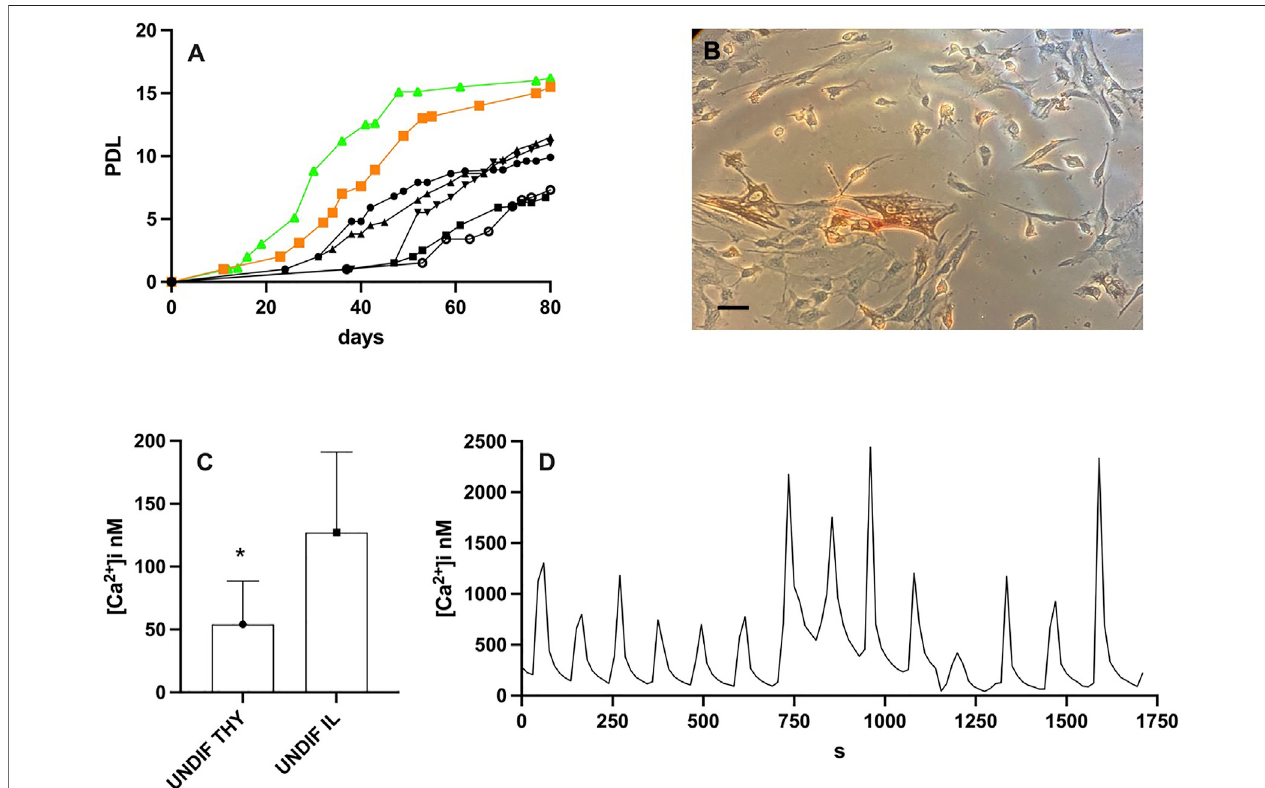
FIGURE 1 | Results on undifferentiated thyrohyoid and ileopsoas hMPCs. (A) Population doubling level (PDL) of postmortem hMPCs derived from thyrohyoid muscle obtained from 40 – (orange squared symbol) and from iliopsoas muscle obtained from 71 – (green triangle symbols) year-old corpses while black symbols representthePDLof fi vedifferenthMPCpopulationsderivedfromvastuslateralisofalivedonorsintherangeof40 – 71 yearsold. (B) PictureofthyrohyoidhMPCsinPetri dishes. (C) The graph shows mean and standard deviation of [Ca 2+ ] i measurement on undifferentiated thyrohyoid (UNDIF THY) and ileopsoas (UNDIF IL) hMPCs. They signi fi cantly differ with p ≤ 0.05. (D) Representative [Ca 2+ ] i oscillation recorded on thyrohyoid hMPCs. The bar in panel B represents 100 μ m.